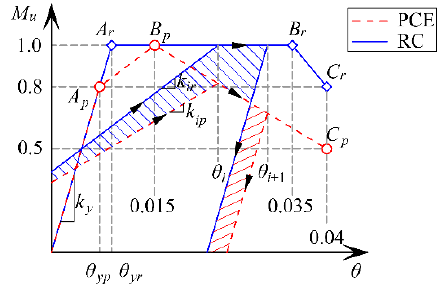
Figure 7. Dimensionless models of PCE joints and RC joints.